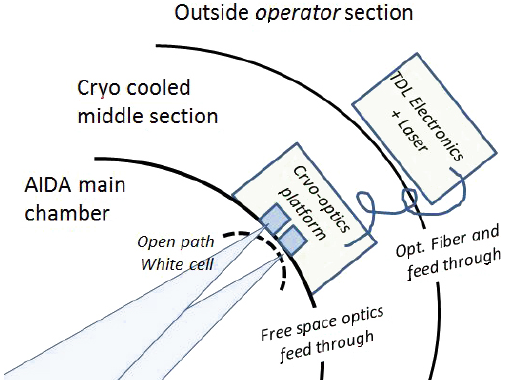
Figure A1. Schematic of the general setup of the APicT spectrome- ter: APicT consists of three parts placed in different segments of the AIDA chamber facility. The parts are connected either via fiber op- tic cables or free-space laser beams. The outer section – including most electronics, data acquisition components, and the diode laser – can be directly operated by the user. The middle section contains a cryogenic transfer optic, including detectors and fiber optics, and is usually only serviced at sufficiently high temperatures (above about − 30 ◦ C). The inner section is connected to the middle section via free-space optics and mainly encompasses the open-path White cell, with opto-mechanic components directly attached to the inner walls of the AIDA chamber (Wagner et al., 2008; Giesemann et al., 2003).